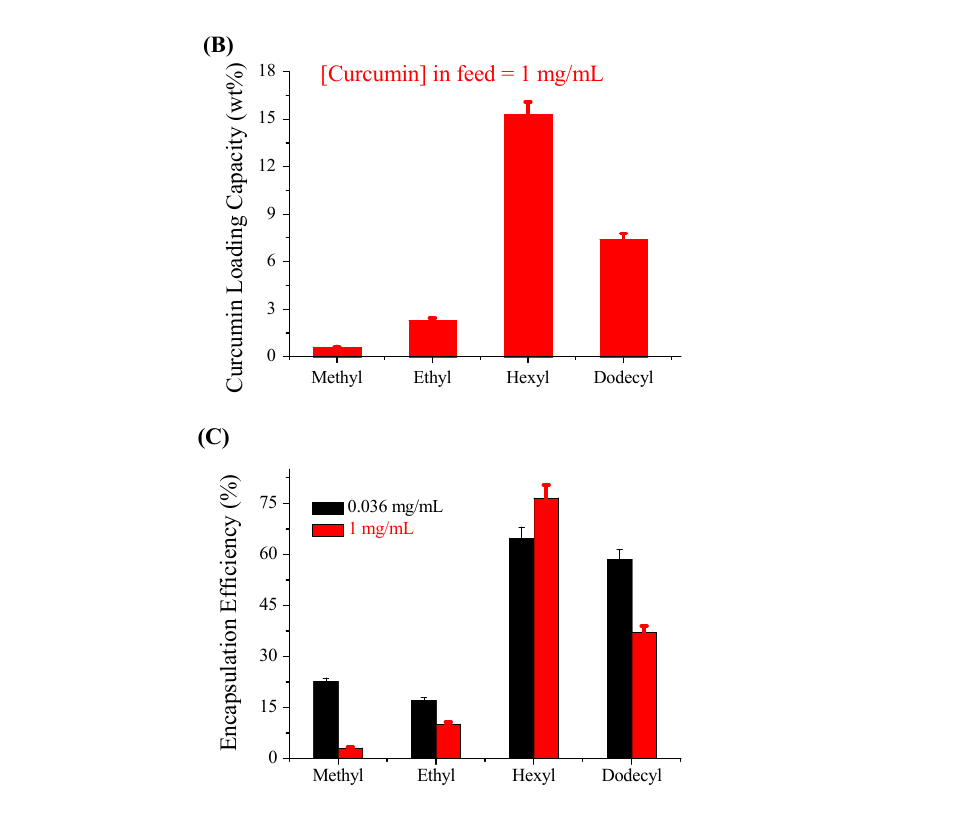
Figure 2. Variation of ( A , B ) curcumin loading capacity and ( C ) encapsulation efficiency of POx NPs with increasing hydrophobic side-chain length (R: Methyl/ethyl/hexyl/dodecyl) in the lipophilic part (ROPhOx) of the copolymer. The feeding concentration of the polymer was 4 mg/mL. The feed- ing concentrations of curcumin were ( A ) 0.036 mg/mL and ( B ) 1 mg/mL. Error bars represent stand- ard deviations from the mean, n = 3 independent